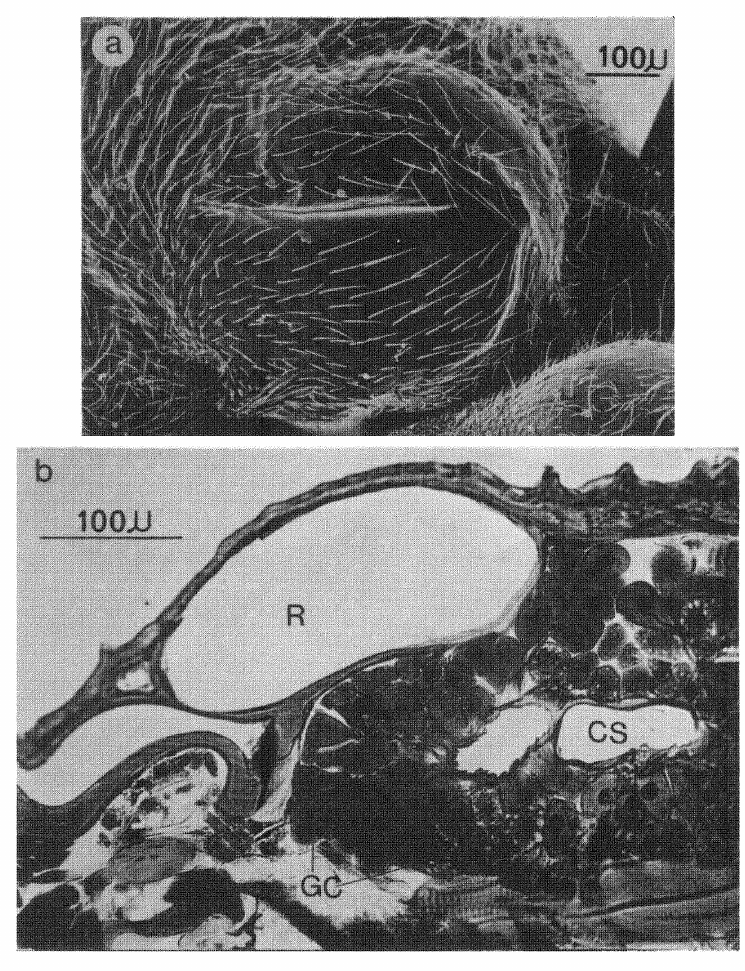
Fig. 2. Metapleural gland of a Nothom.vrmecia macrops worker, a. SEM micrograph of meatus, b. Longitudinal section through the metapleural gland. CS collecting sac; GC glandular cells; R storage